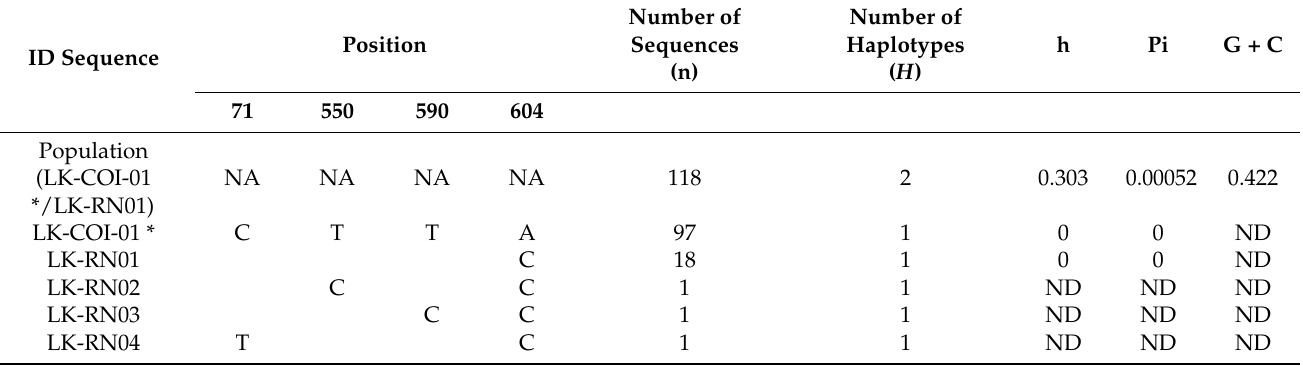
Table 1. Mitochondrial haplotypes were obtained for 118 COI sequences from Kemp’s ridley ( Lepidochelys kempii ) in BOLD and field samples collected in Mexico, 2018 – 2019; Nucleotides change positions related to the consensus sequence (113 or 716, GenBank accession, respectively), number of sequences (n), number of haplotypes ( H ), nucleotide (Pi), and haplotype (h) diversities, and G +